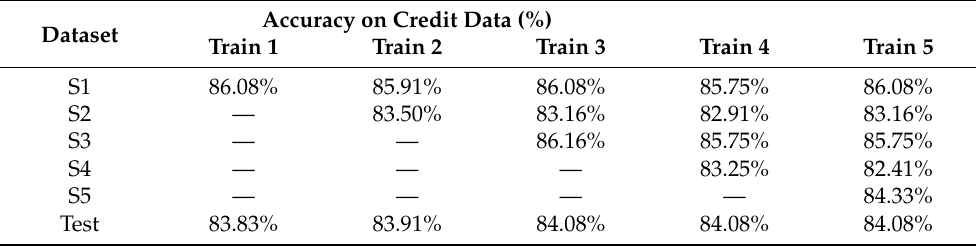
Table 5. Result of ISVM_DD on credit data.